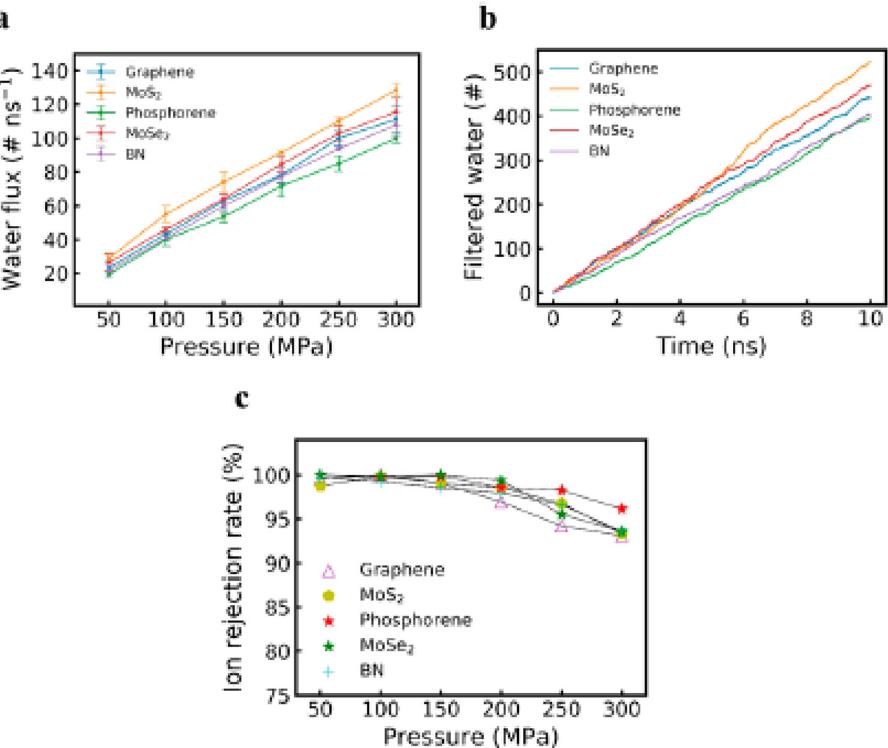
Fig. 2 Comparisons for the different 2D materials. a Applied pressure effect ( b ) water molecules fi ltered ( c ) Ions rejection (potassium and chlorine) as function of the applied pressure. Reproduced with permission from ACS Energy Lett. 5, 7 (2017). Copyright 2020 American Chemical Society 41